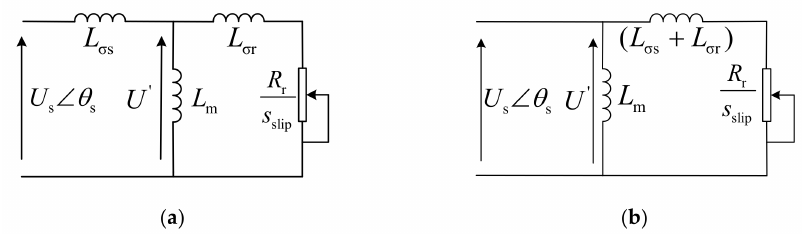
Figure 1. ( a ) Asynchronous motor initial circuit. ( b ) Asynchronous motor equivalent